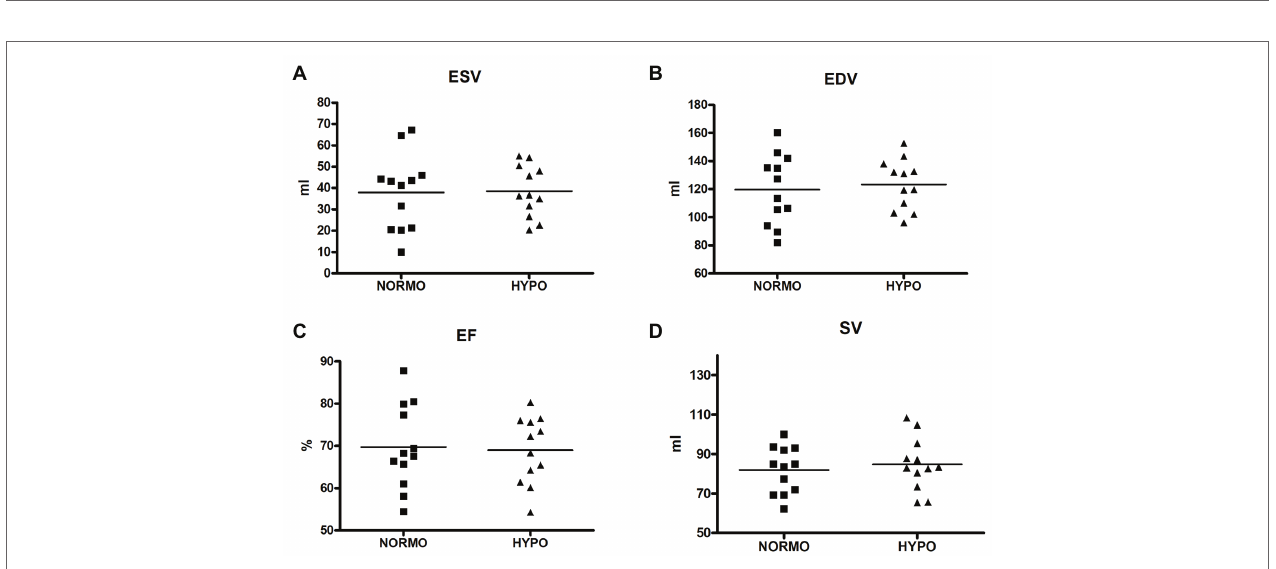
FIGURE 1 | Scatter plot graphs of levels of blood O 2 saturation (SO 2 , panel A ), heart rate (HR, panel B ), mean arterial pressure (MAP, panel C ), pre-ejection period (PEP, panel D ), ventricular ejection time (VET, panel E ), and diastolic time (DT, panel F ) during the recovery from sessions of exercise in normoxia (NORMO) and in normobaric hypoxia with a FiO 2 of 13.5% (HYPO). N = 12. * p < 0.05 vs. NORMO test.